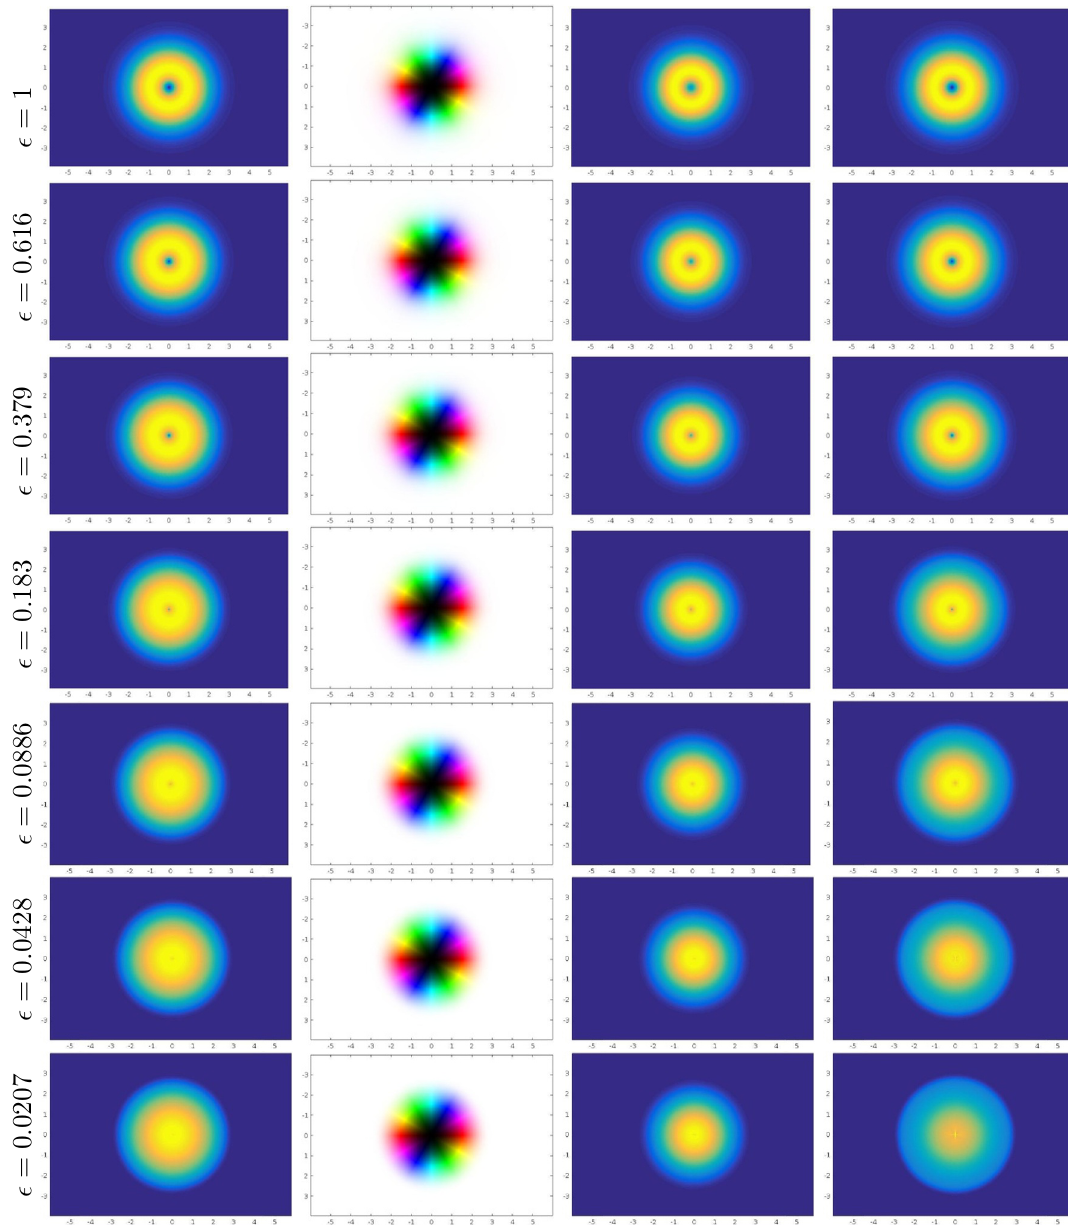
Figure 8 . The N = 2 baby-Skyrmion solution as a function of (cid:15) , which is the stable Q = 2 soliton. The columns display the topological charge density, the field orientation using the color scheme described in the text, the total energy and finally the kinetic term − (cid:15) L 2